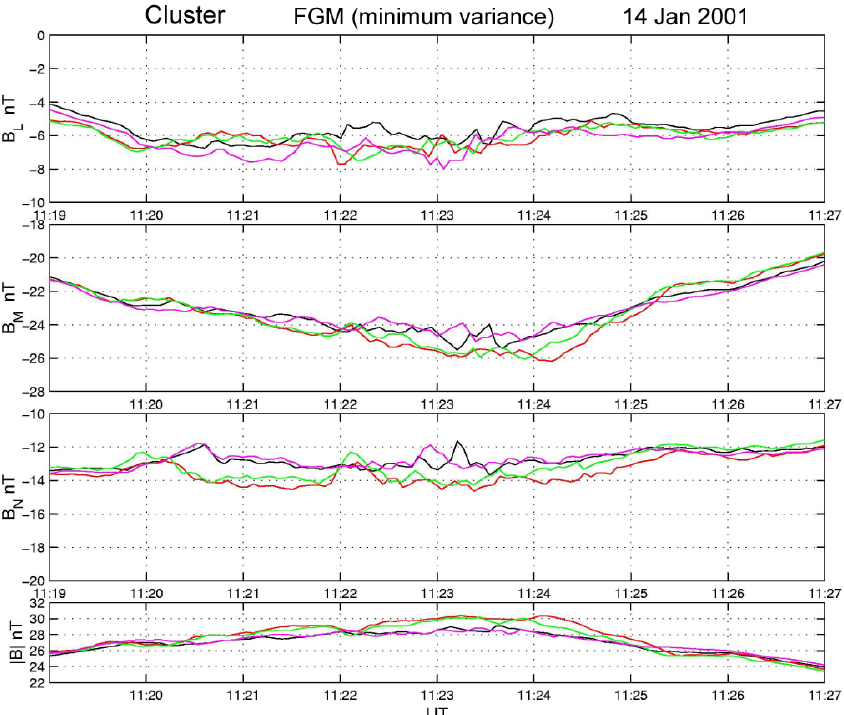
Fig. 11. The magnetic field observed by the four Cluster spacecraft during 11:19–11:27UT on 14 January 2001. The plots shows the B L , B M and B N components (in the boundary-normal frame described in the text) and the field magnitude | B | . Data from spacecraft C1, C2, C3 and C4 are coloured (respectively) black, red, green and